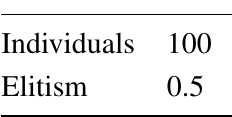
Table 5. Parameters used in MIMIC.